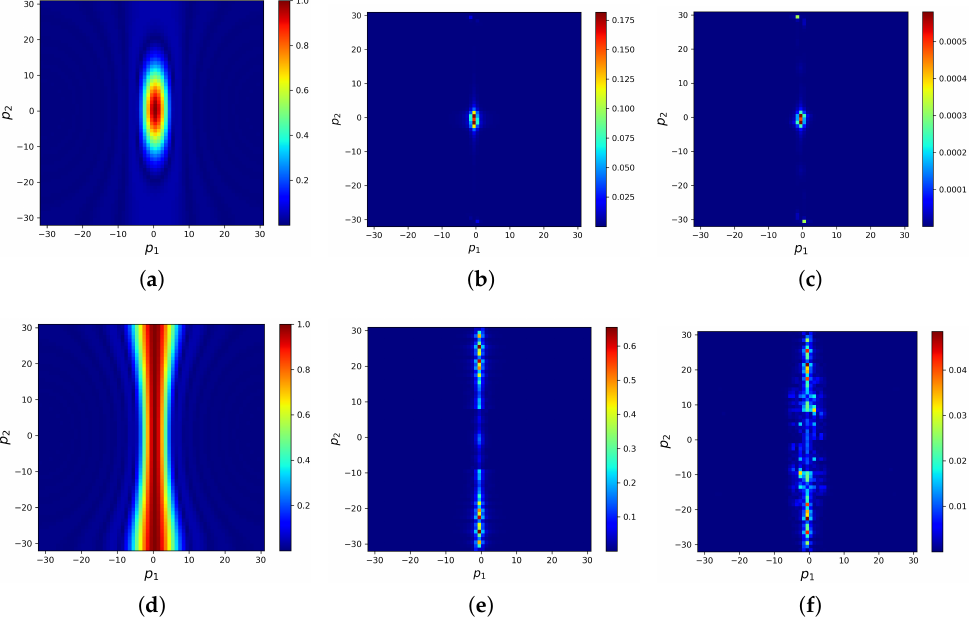
Figure 4. Distribution of convergence factor when ξ = 10 − 1 ,10 − 6 . The first column displays the convergence factor of Cheby-semi ( m = 10). The second column shows the error distribution in the frequency space before correction. The third column shows the error distribution in the frequency space learned by H . ( a ) ξ = 10 − 1 : convergence factor of Φ . ( b ) ξ = 10 − 1 : ˆ e , before doing corrections.